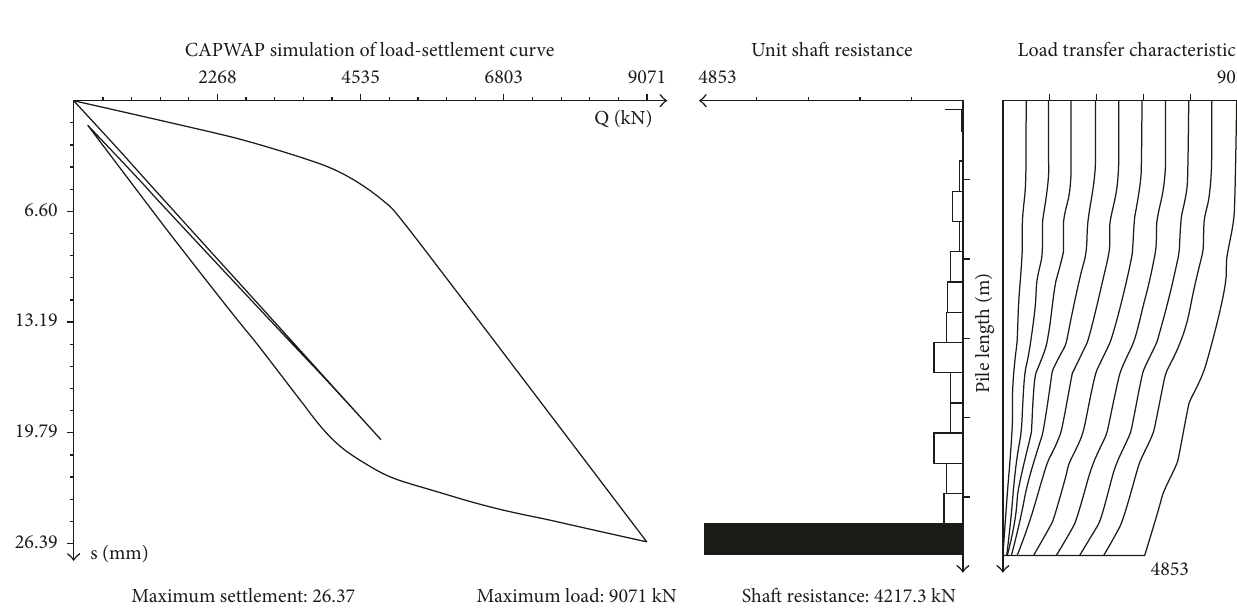
Figure 14: CAPWAP results of